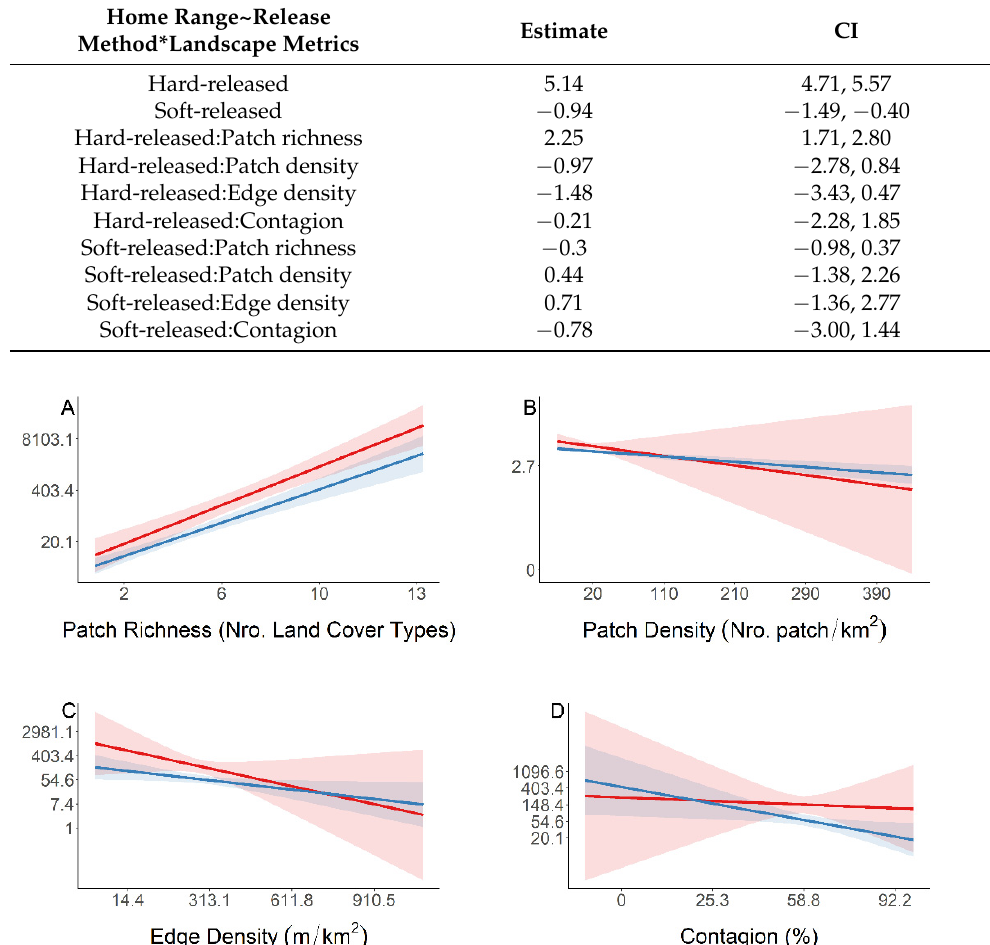
Figure 3. Marginal effects of the release methods and landscape metrics on the space use (home range size) of captive-reared and wild-rehabilitated Harpy Eagles ( Harpia harpyja ) in Central American landscapes. Red and blue lines correspond to hard- and soft-released individuals, respectively. The vertical axis is a natural logarithmic scale (back-transformed to km 2 ). The color shadows represent 95% confidence intervals.